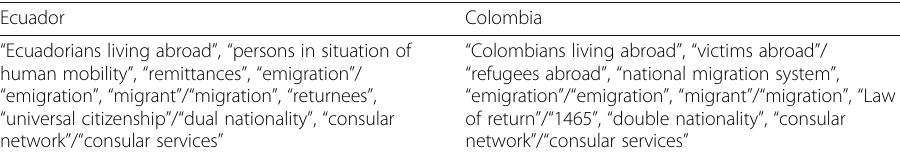
Table 2 Dictionary used to code speeches. Tokens translate by author from the original versions (in Spanish). Detailed list of tokens used available on demand. Source: Author ’ s